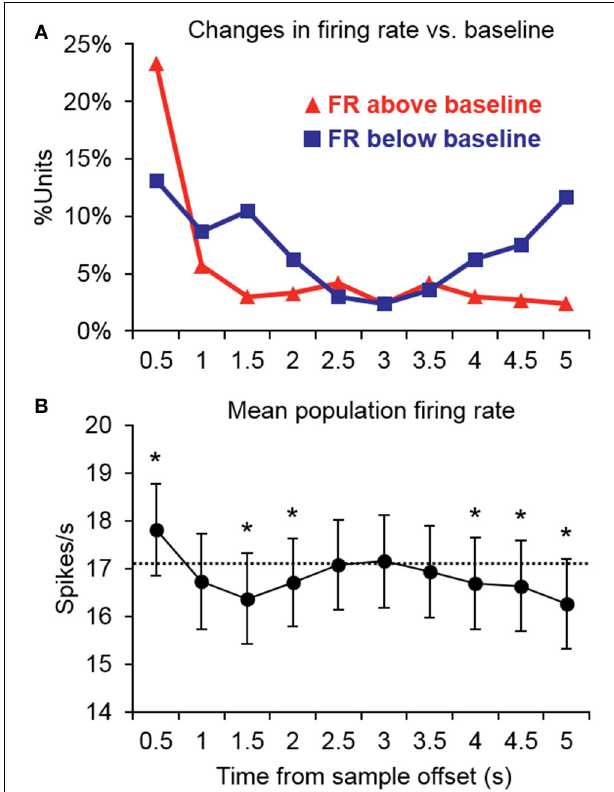
FIGURE 3 | Summary of significant changes in firing rate from baseline during the retention interval. (A) Many units exhibited increased firing rates immediately after the offset of the sample stimulus, but for the majority of units, firing rates returned to baseline